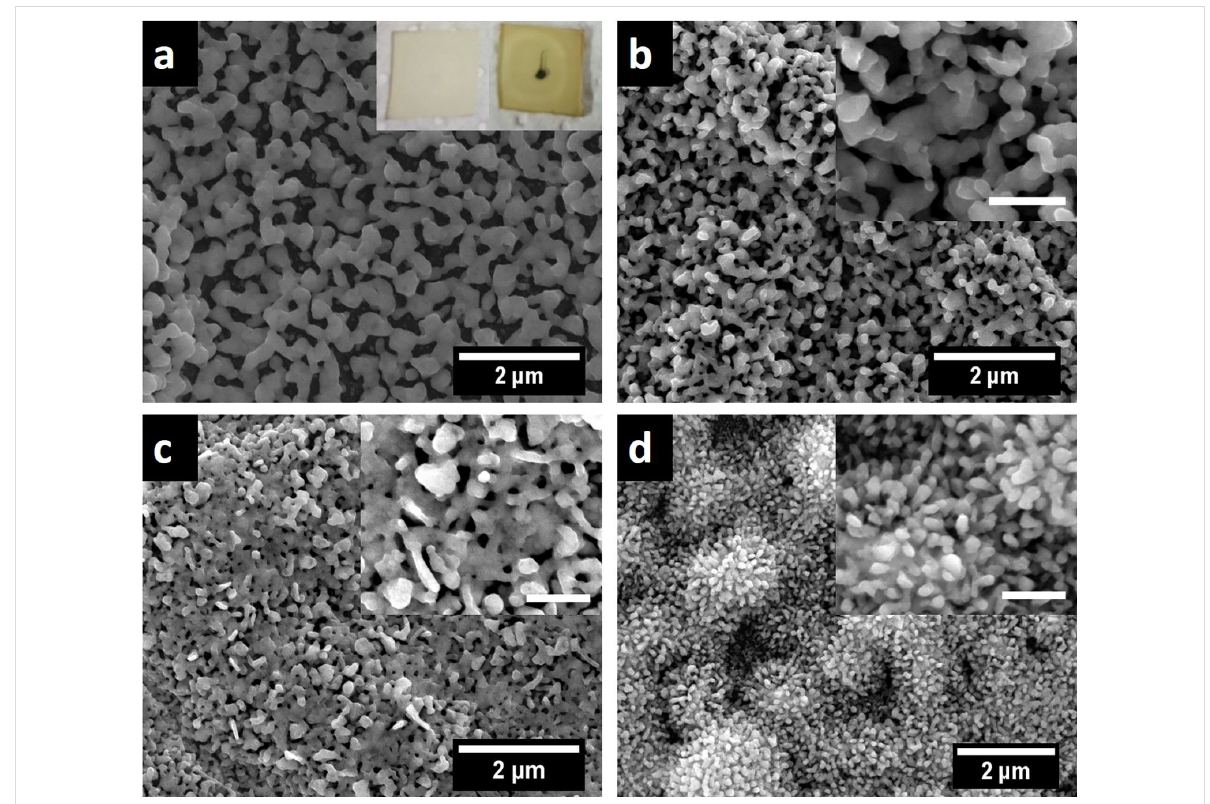
Figure 8: SEM images of a 200 nm sputtered silver film treated with (a) a mixture of argon (8 sccm) and oxygen (4 sccm) in an rf plasma (200 W) for 15 min followed by reduction using a pure argon plasma (g16.7-p200) for 15 min; the inset displays a photograph of the top and the bottom (with black spot) side of the silver film on glass, (b) air plasma (g12-p200) for 15 min followed by reduction with argon plasma (g16.7-p200) for 20 min, (c) air plasma (g12-p200) for 30 min followed by reduction with argon plasma (g16.7-p200) for 20 min and (d) 200 nm sputtered silver film heated at 400